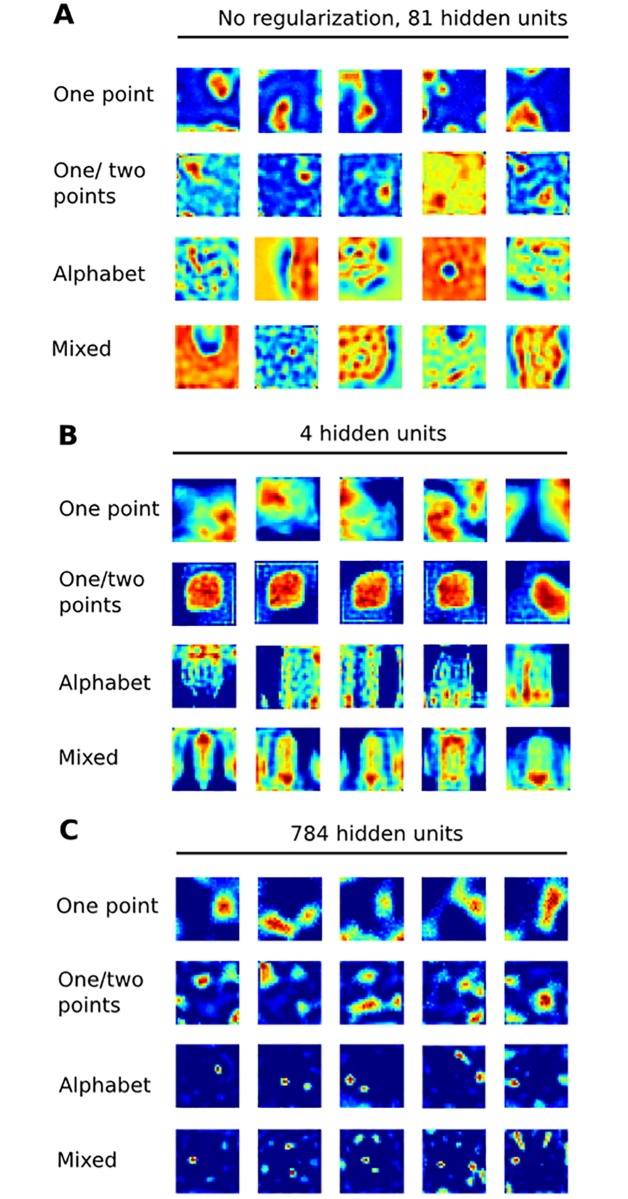
Alternative architectures.Same format as Fig 2 but showing exemplar receptive fields learned by three alternative networks featuring architectures with relaxed constraints.